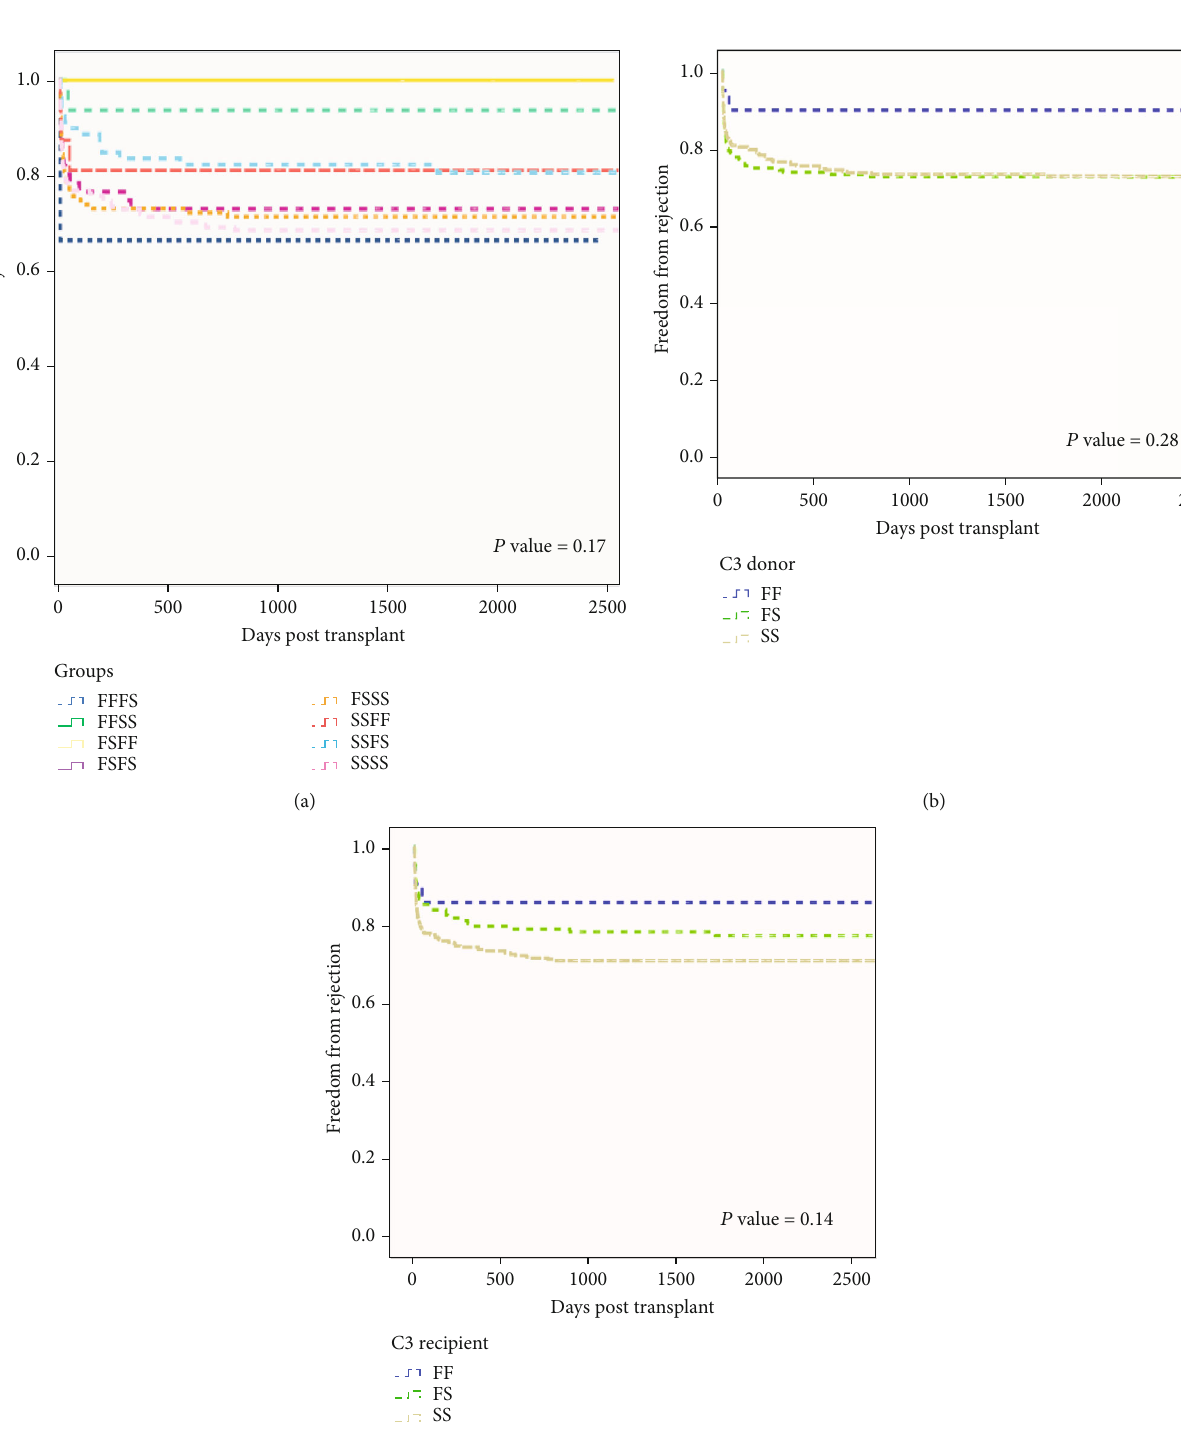
Figure 4: Acute allograph rejection by complement C3 genotype. Freedom from rejection. Numbers at risk and log-rank ( P values are shown) up to 2500 days. Paired groups (a) and donor and recipient individual groups (b, c) according to C3 genotype and presence of C3F allele (b, c) P = 0 : 17 for genotype groups. (a) Donor ’ s presence or absence of C3F allele, P = 0 : 28 ; (c) recipient ’ s presence or absence of C3F allele P = 0 : 14